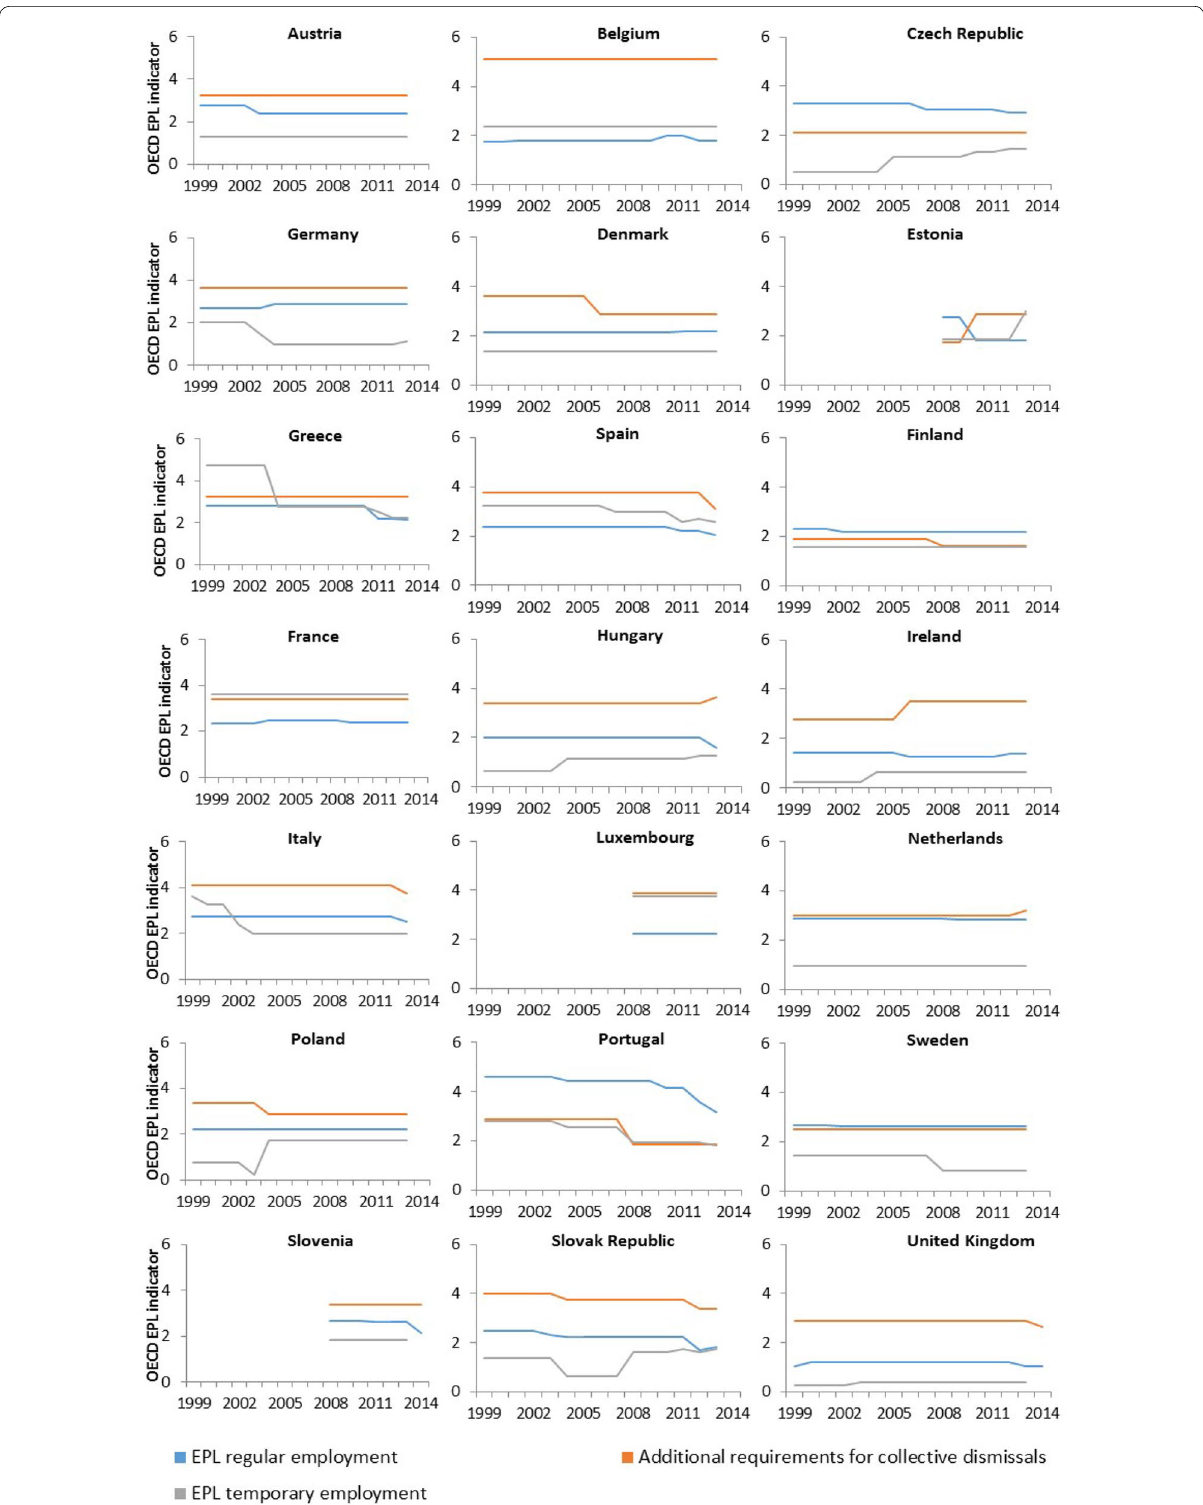
Fig. 6 Changes in the OECD EPL index ( Source OECD Employment Protection Database, as shown in European Commission (2016), pp.